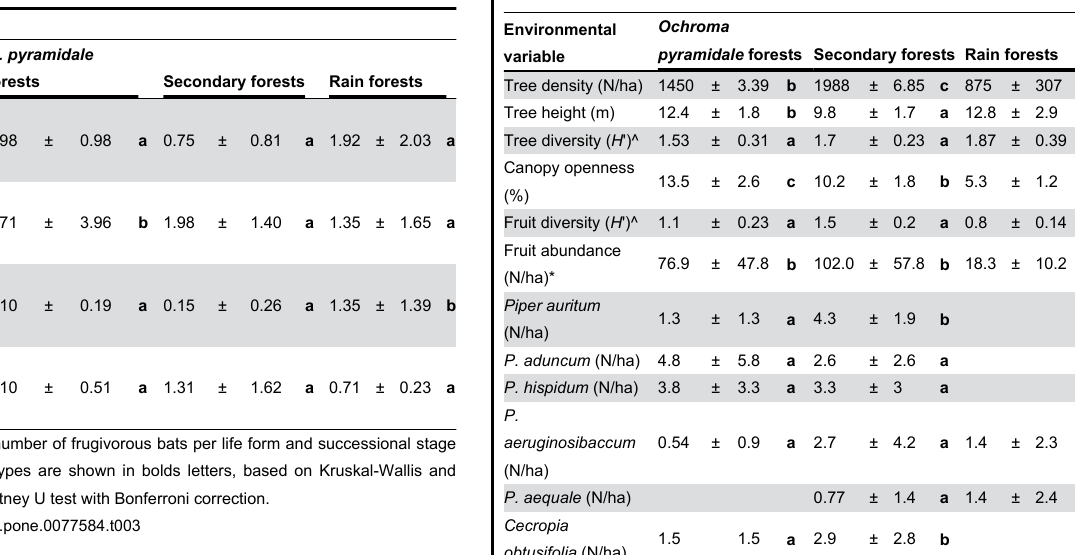
Table 4. Vegetation structure, and monthly fruit diversity, abundance and availability of Piper and Cecropia species per ha, per forest type with Ochroma pyramidale forests, secondary forests and rain forests.